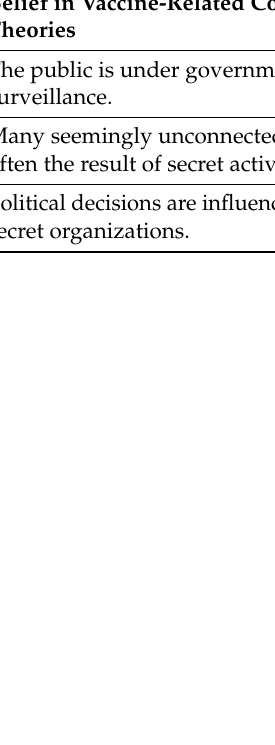
Table 7. Nationalism score of participants ( n =